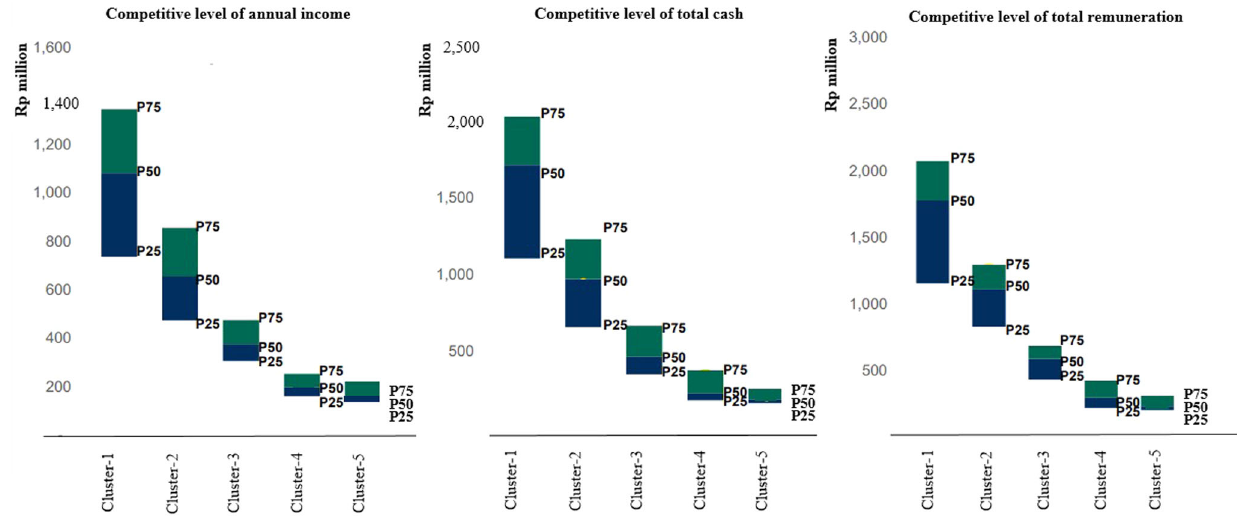
Fig. 3 The competitive level between clusters. We distributed in three different views of competitive level of annual income, total cash, and total remuneration. Annual income is basically a normative as stipulated by each of organization, meanwhile, total cash to describe additional cash to add annual income and the sum of it is total remuneration of workers